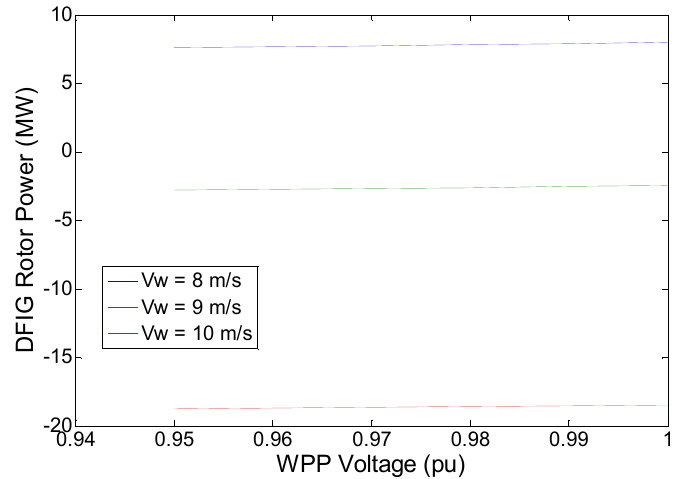
Figure 8. Variation of DFIG active power.